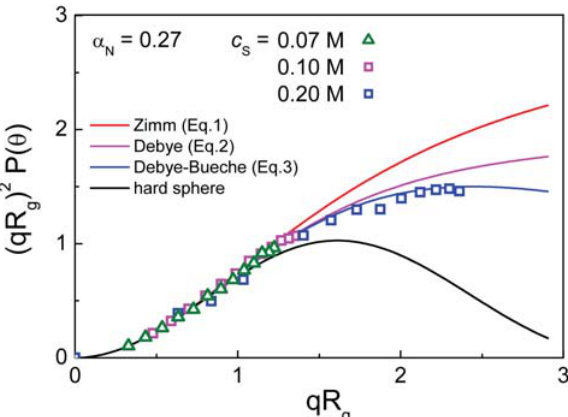
Figure 5. The dependence of ( qR particle topologies (calculated according to Equations 1-Zimm, 2- Debye, and 3-Debye-Bueche) and the experimental data (points) for large particles (i.e. aggregates) in iPMA solutions with c g/L and α = 0.27 and at three different CsCl concentrations: c N 0.07, 0.10, and 0.20